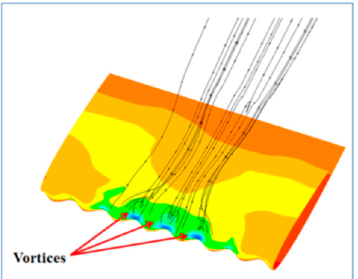
Figure 9. Three-dimensional streamlines of an airfoil (R = 1.0).